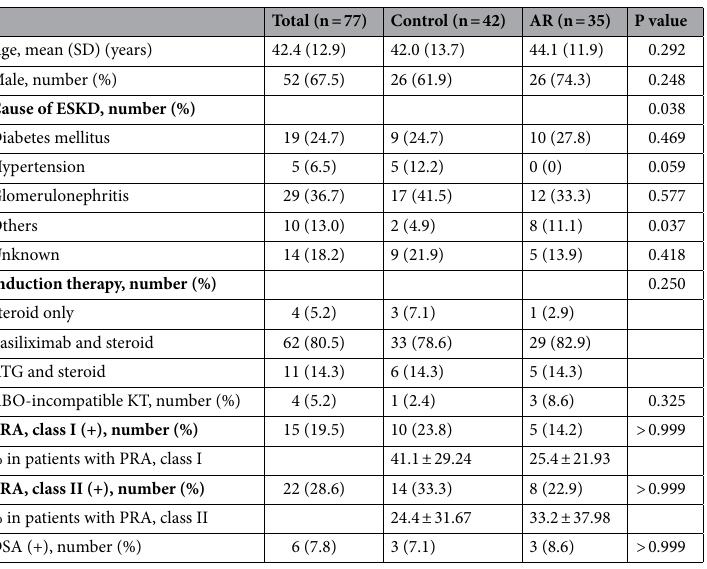
Table 1. Baseline characteristics, induction therapy for kidney transplantation, and immunologic risk factors of the original cohort. Continuous variables are expressed as mean (standard deviation) and categorical variables are expressed as number (percentage). Others for cause of ESKD included autosomal dominant polycystic kidney disease, lupus nephritis, obstructive nephropathy, and Alport syndrome. % in patients with PRA: mean ± standard deviation. AR acute rejection, ATG anti-thymocyte globulin, DSA donor specific antibodies, ESKD end-stage kidney disease, KT kidney transplantation, PRA panel reactive antibodies, SD standard